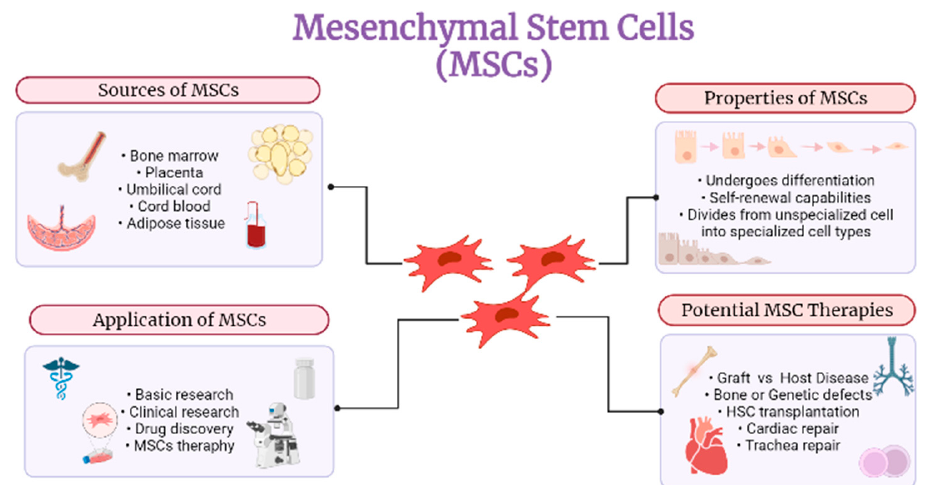
Figure 2. The overview of Mesenchymal Stem Cells (MSCs).